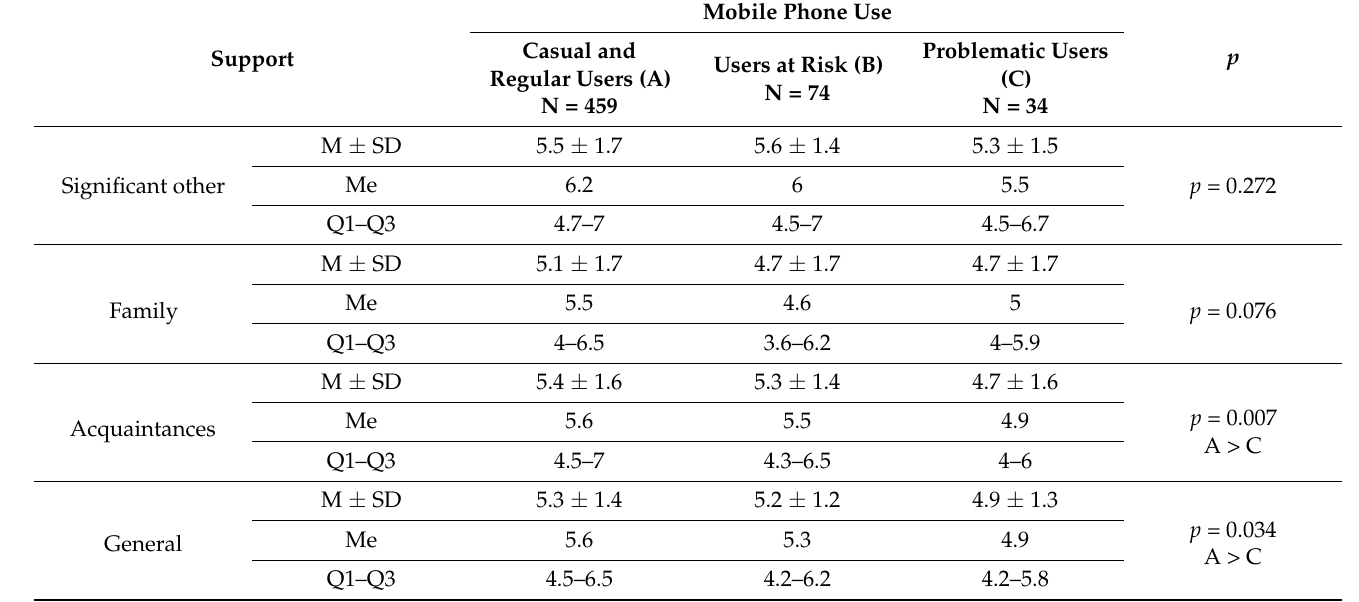
Table 1. The analysis of correlation between mobile phone use according to the MPPUSA and social support according to the MSPSS in the surveyed